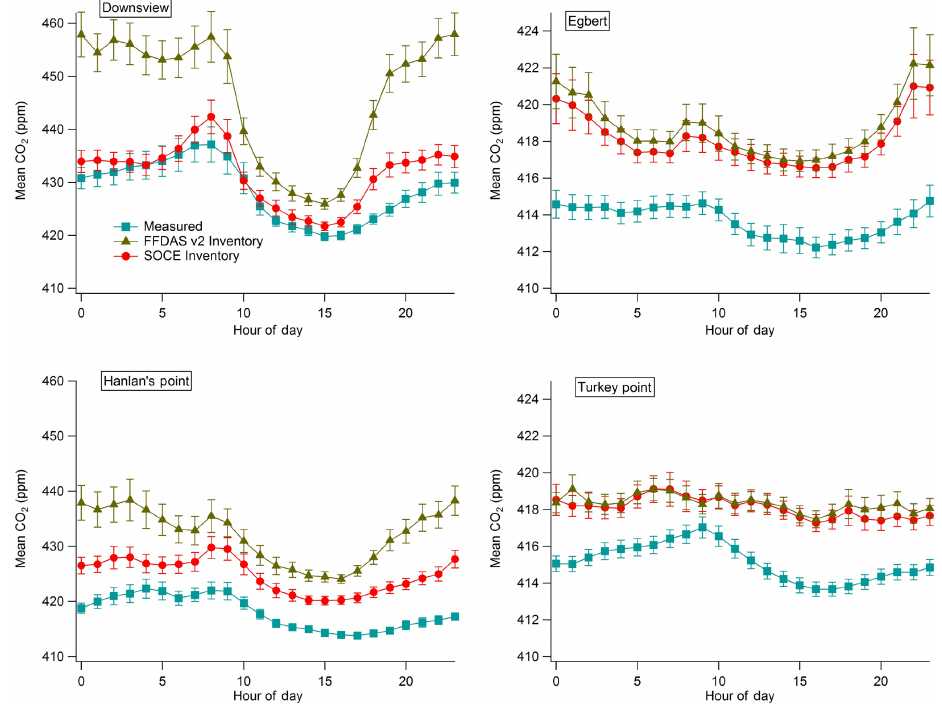
Figure 5. Time series of mean measured (blue) and modelled diurnal CO 2 mixing ratios at the four sites considered in this study for January–March 2016. The red and gold markers are the modelled diurnal mixing ratios when using the SOCE CO 2 inventory and the FFDAS v2 inventory, respectively. Note the difference in scale for urban and rural sites. Error bars represent standard error of the mean.